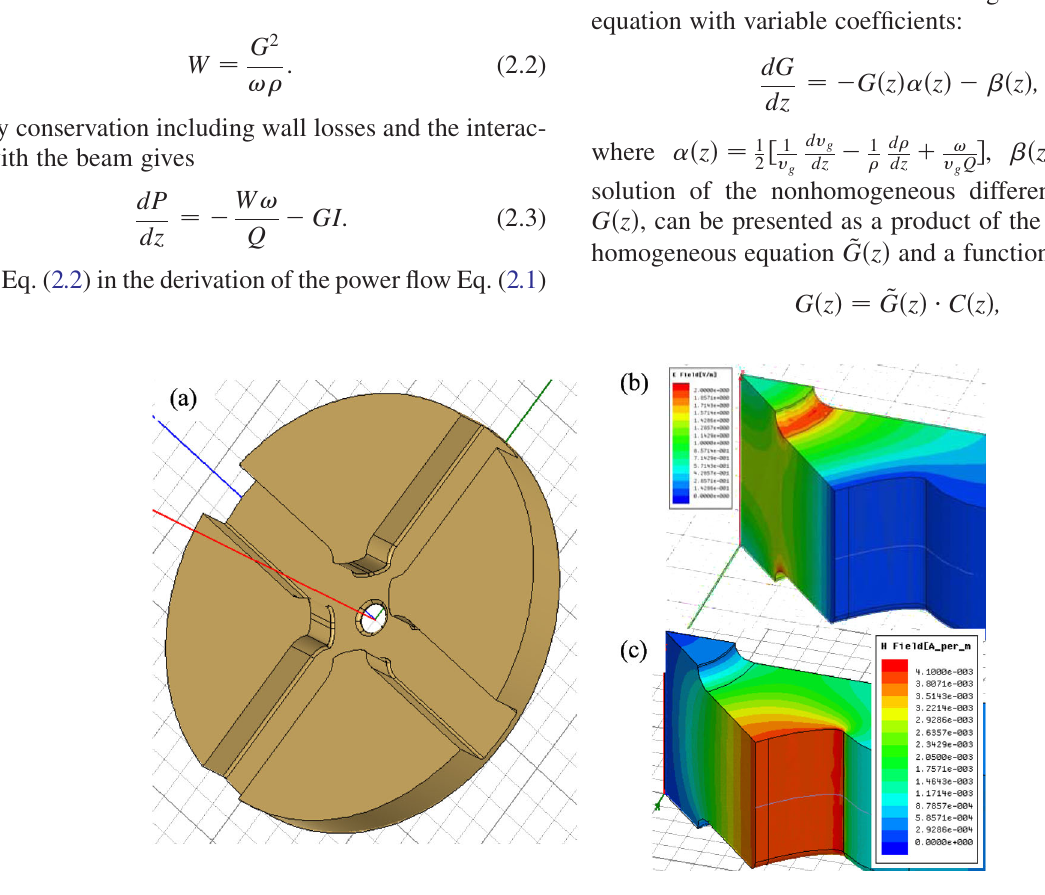
FIG. 1. Individual cell geometry of the CLIC main linac accelerating structure with strong waveguide high order modes damping (a), HFSS simulations of the surface electric (b), and magnetic (c) fields are